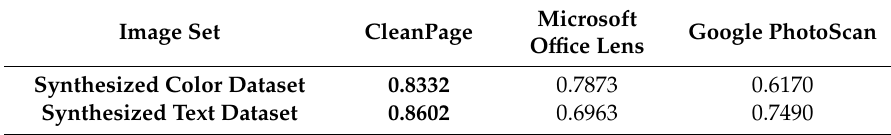
Table 3. Comparison of scanning methods using Structural Similarity score (SSIM) to compare each scan to synthesized reference images. Results presented are the average score across each full dataset. Higher scores indicate greater similarity to the original unscanned